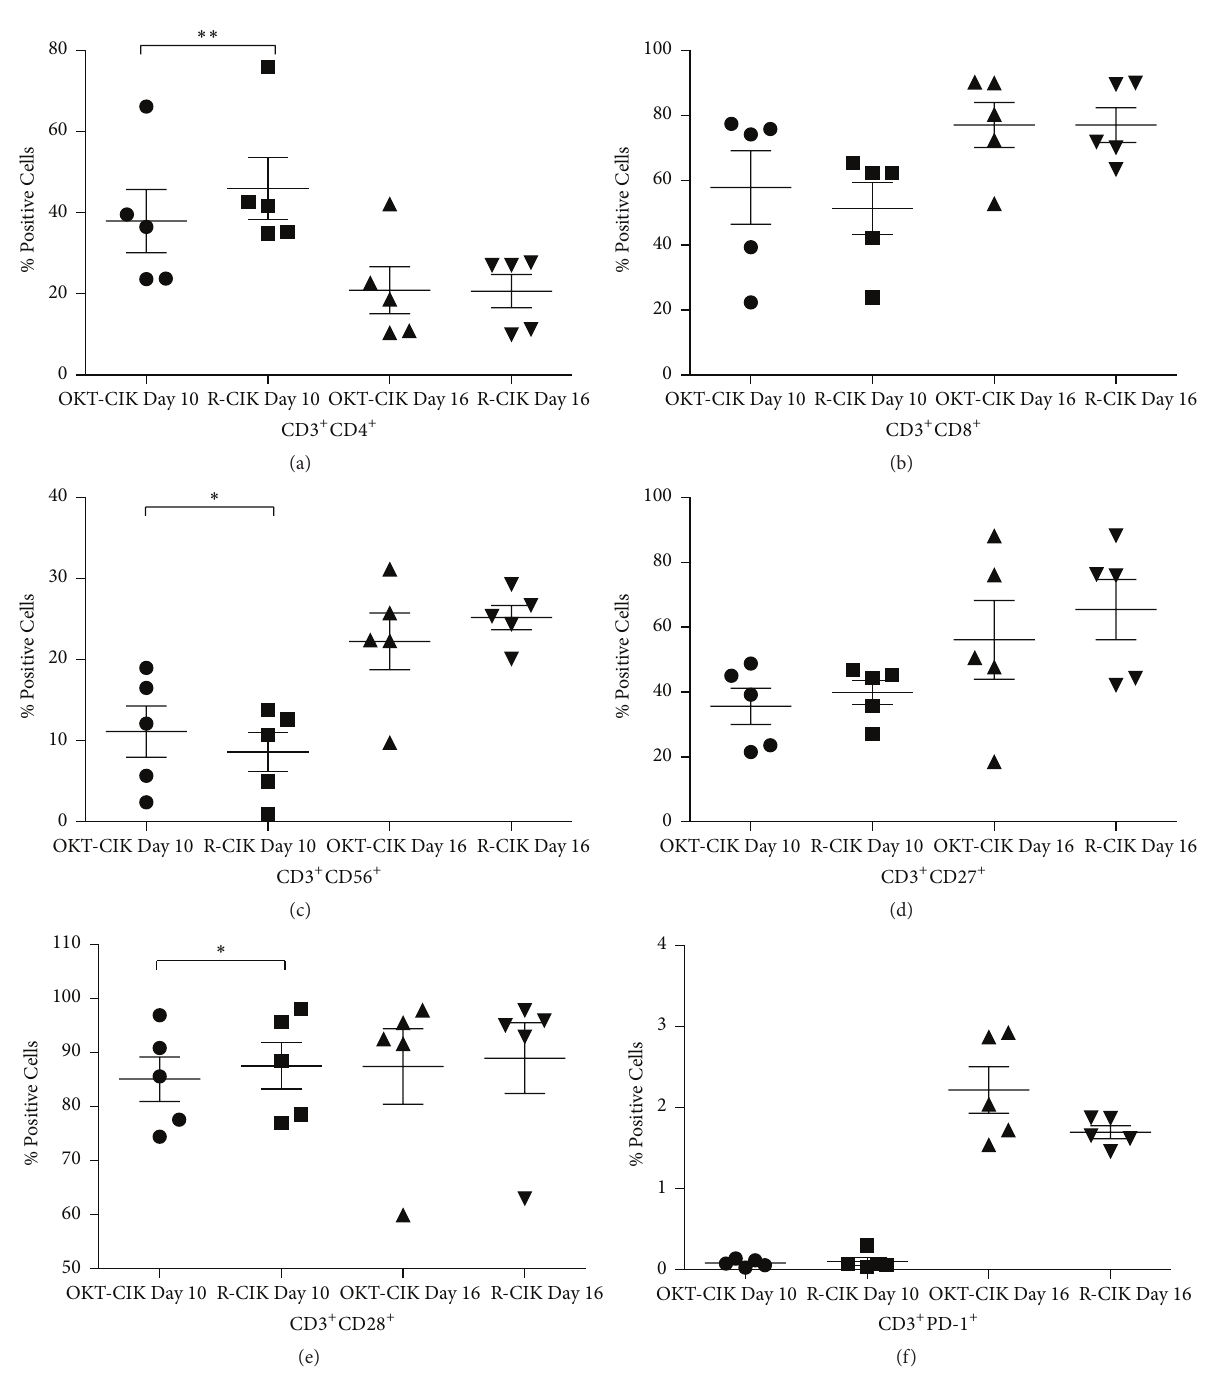
Figure 2: Composition of T subpopulation cells at different culture times. (a) CD3 + CD4 + T cells cultured on the 10th and 16th day. (b) CD3 + CD8 + T cells cultured on the 10th and 16th day. (c) CD3 + CD56 + T cells cultured on the 10th and 16th day. (d) CD3 + CD27 + T cells cultured on the 10th and 16th day. (e) CD3 + CD28 + T cells cultured on the 10th and 16th day. (f) CD3 + PD-1 + T cells cultured on the 10th and 16th day. CD3 + CD4 + and CD3 + CD28 + cells were higher in R-CIK cells, while CD3 + CD56 + cells were lower in R-CIK cells on the 10th day, but they became equal on the 16th day. There was no difference seen between the OKT-CIK and R-CIK cells when compared to other subpopulation cells. As the culture time prolonged, CD3 + CD8 + cell counts were raised in both OKT-CIK and R-CIK cells, and CD3 + CD4 + cells decreased in both OKT-CIK and R-CIK cells at the same time. The % of the cells shows the % of cells in all cell population in the culture. ∗ 𝑃 < 0.05 ; ∗∗ 𝑃 < 0.01 for the comparison, 𝑛 = 5